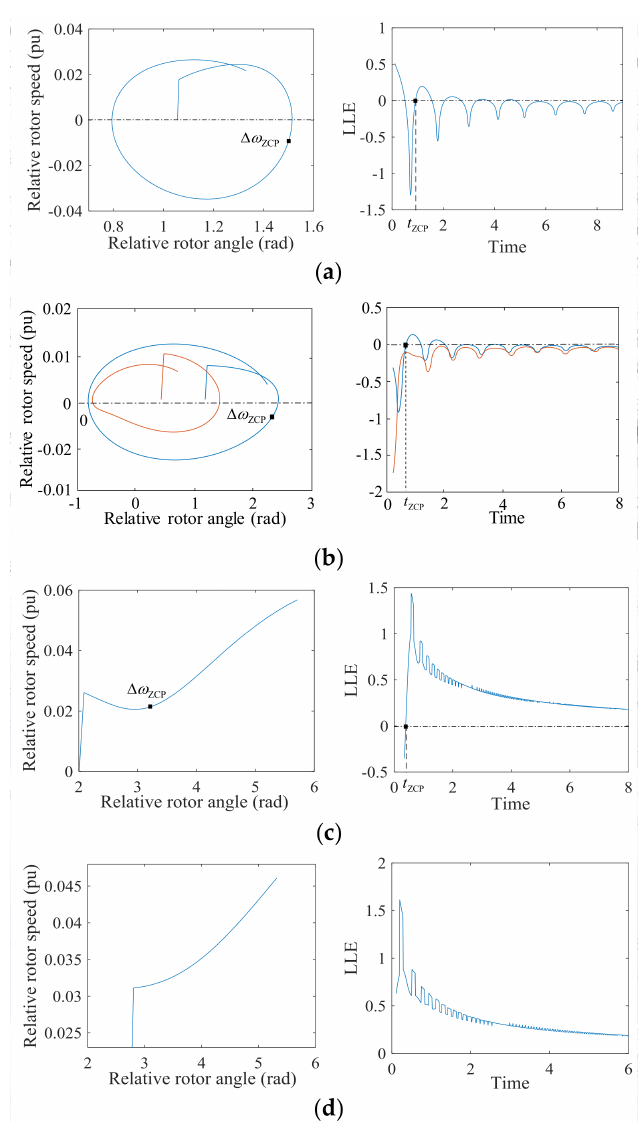
Figure 3. Phase-plane trajectories after clearing fault and corresponding LLE–time curves of a GP under different stability conditions: ( a ) Stability Condition 1 and the corresponding LLE–time curve; ( b ) Stability Condition 2 and the corresponding LLE–time curve; ( c ) Stability Condition 3 and the corresponding LLE–time curve; ( d ) Stability Condition 4 and the corresponding LLE–time